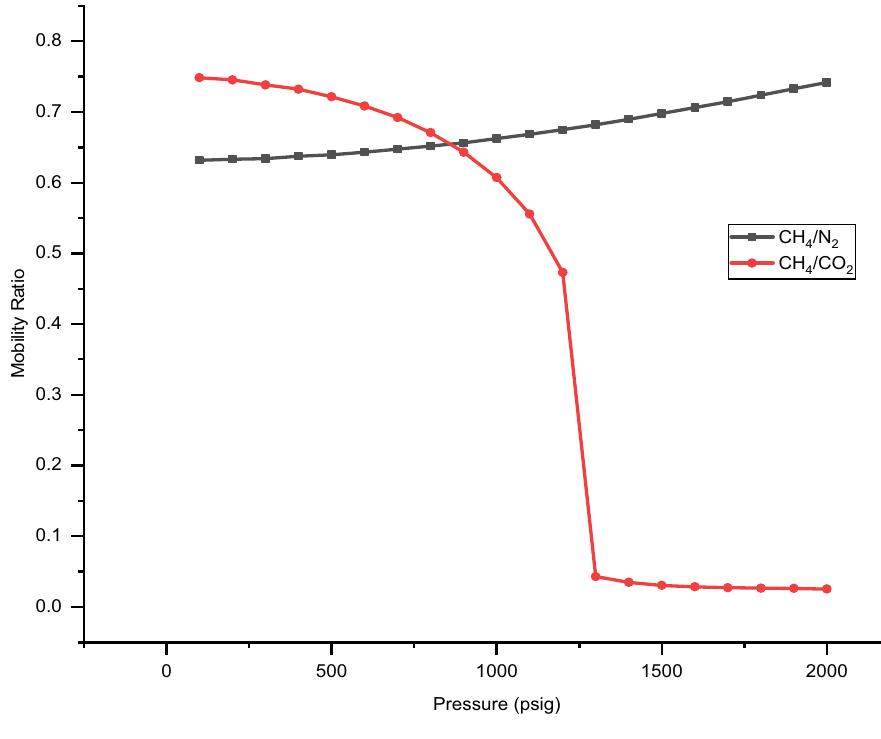
Fig. 5 CH 4 –N 2 and CH 4 –CO 2 mobility ratios as a function of pressure at 40 °C